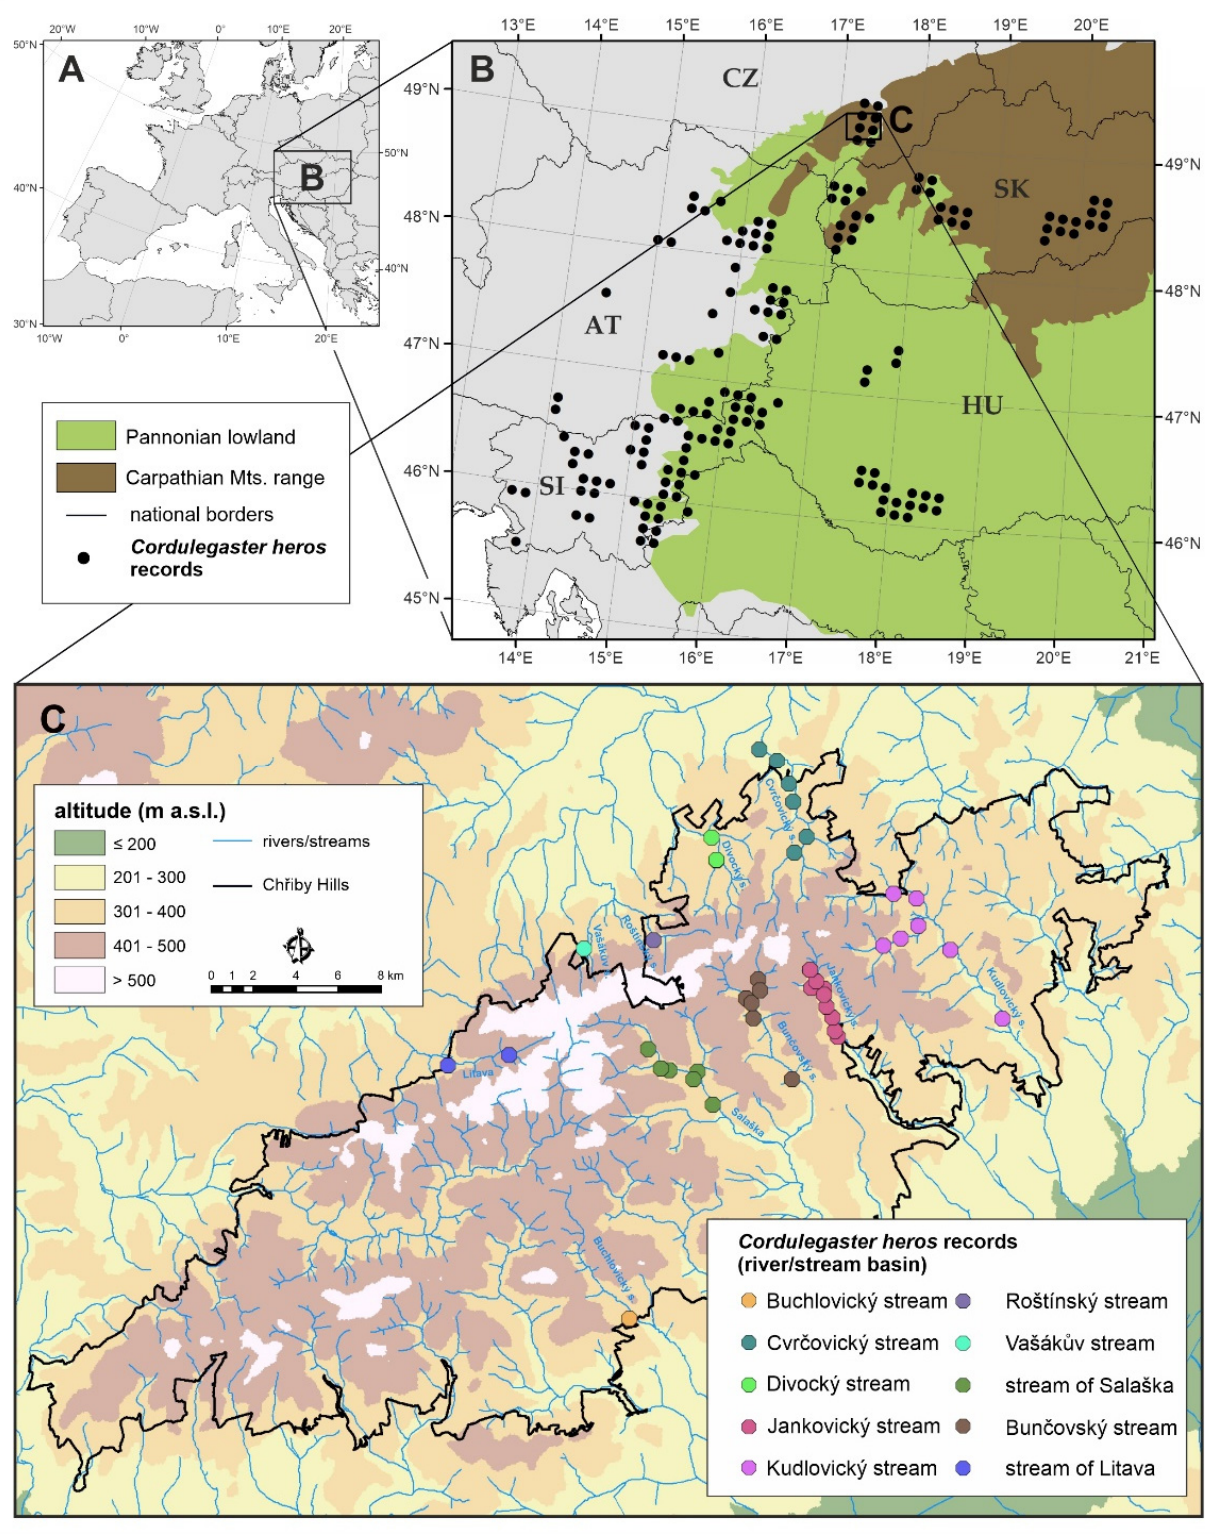
Figure 1. Known records of Cordulegaster heros in the Czech Republic (state as of 30 June 2022). ( A ) Map of western, south and central Europe ( B ) Map of central Europe with records of C. heros (AT—Austria, CZ—Czech Republic, HU—Hungary, SI—Slovenia, SK—Slovakia) ( C ) Region of the Ch ř iby Hills in the Czech Republic with C. heros records in individual watershed.